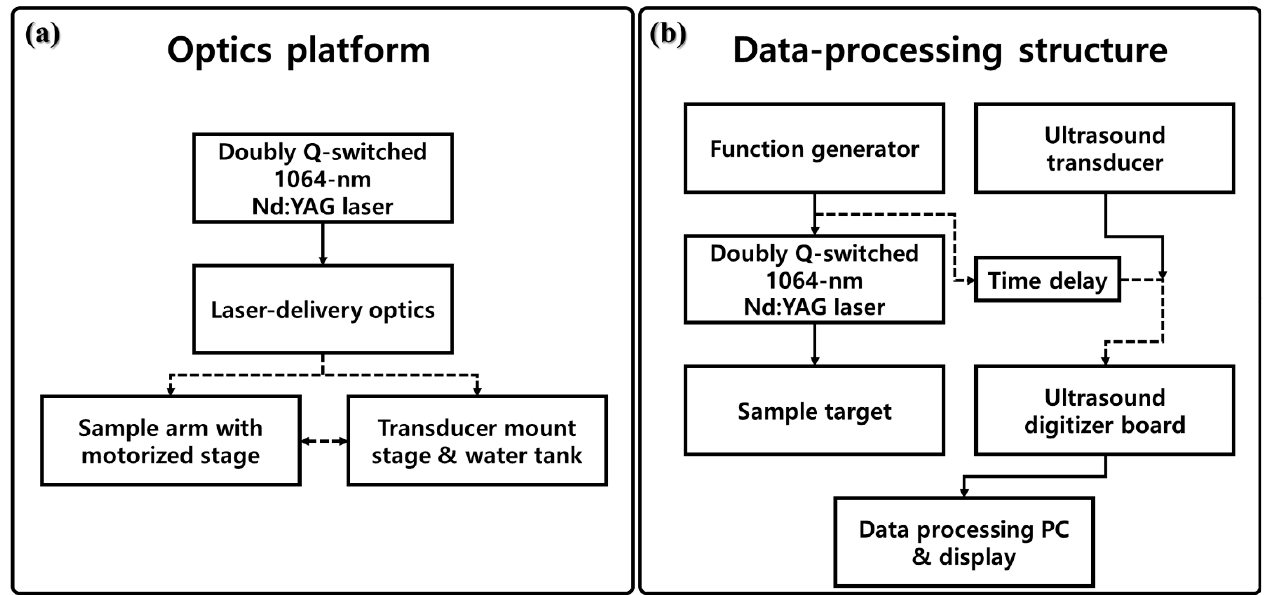
Figure 5. Connection structure for the modules of the implemented PA imaging system: ( a ) optics platform and ( b ) data-processing structure.